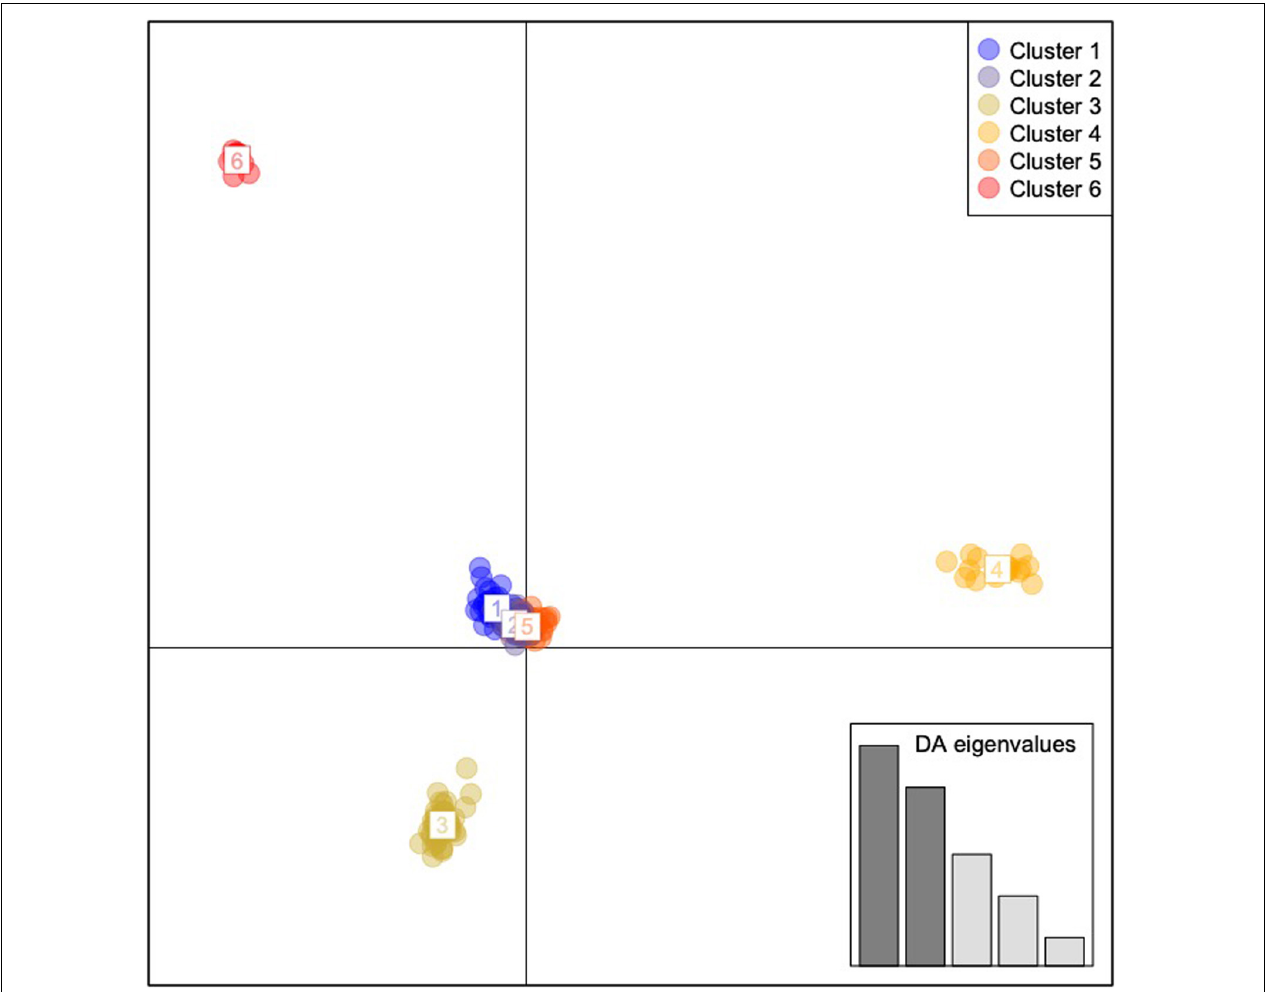
FIGURE 3 | Discriminant Analysis of Principal Components for Channa argus single nucleotide polymorphism data. Cluster 1: all of the fish collected from the Bohu and Liangzi Lakes in China, 1.7% (1 of 59) of the fish collected from the Upper Hudson River basin, all of the fish collected from the Lower Hudson River basin, and all of the fish from the Chinatown, Manhattan fish market. Cluster 2: 1.9% (1 of 54) of the fish collected from the Potomac River basin and all of the fish collected from Philadelphia. Cluster 3: 98% of the fish collected from the Potomac River basin (53 of 54). Cluster 4: all of the fish collected from Arkansas. Cluster 5: 98% (58 of 59) of the fish that were collected from the Upper Hudson River basin. Cluster 6: All individuals sampled from Poyang Lake,